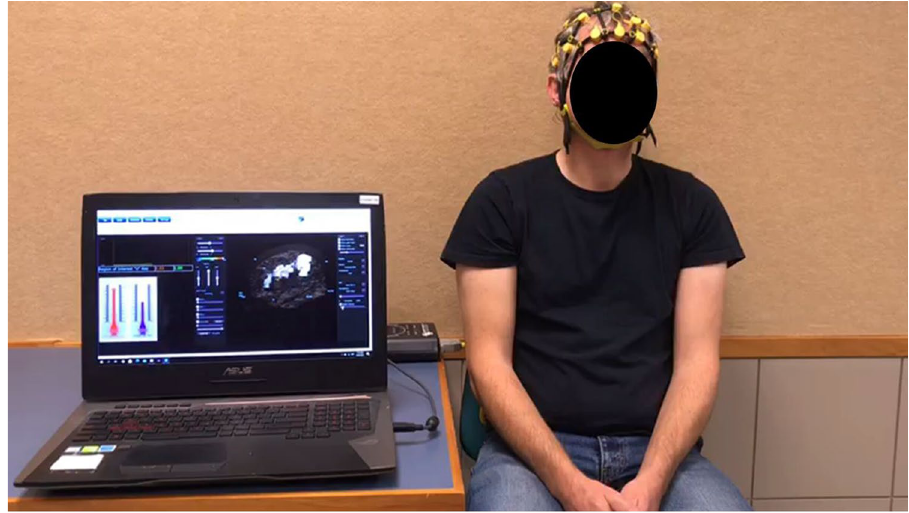
Figure 2. EEG ISF-NF intervention